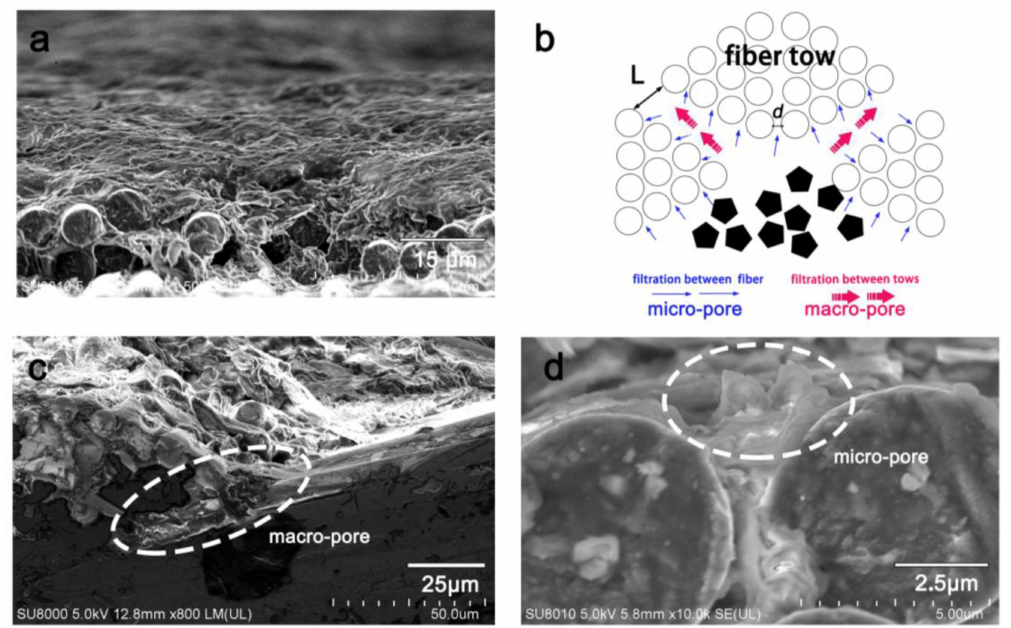
Figure 4. Schematic explanation of the graphene coating preparation: ( a ) C-0.005 g, ( b ) illustrations of graphene flow in the fibrous fabric, magnified images of macropore ( c ) and micropore ( d ) in the coating preparation.